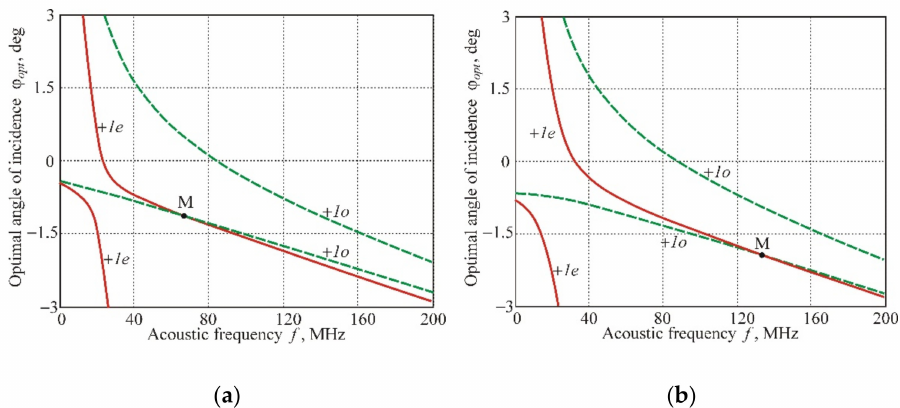
Figure 8. Frequency dependences of optimal angles for branches +1 е and +1 о : calculation for ( a ) d = 0.22 mm, and ( b ) d = 0.2